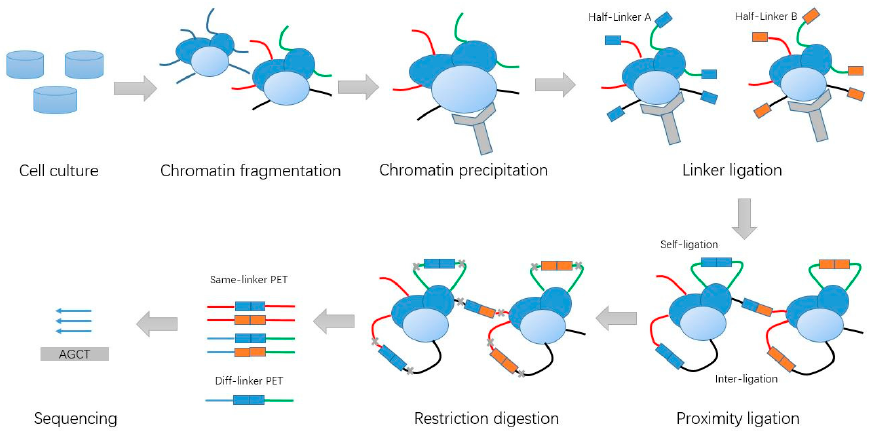
Figure 1. Schematic of Chromatin Interaction Analysis with Paired-End Tag (ChIA-PET) experiment steps.